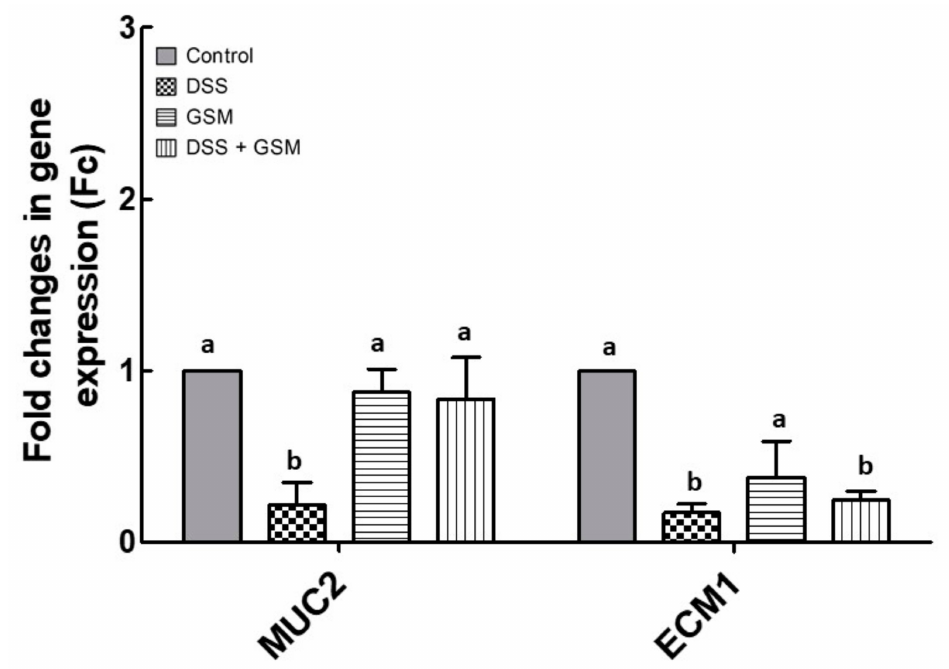
Figure 5. The effects of dietary treatments on genes are associated with barrier function damage in colon. MUC-2 and ECM1 gene expressions were evaluated in the colon of DSS-treated piglets by qPCR. The expression of target gene was normalized to the geometric mean of two reference genes; the results, expressed as fold changes (Fc) are presented as mean ± SEM. Values are the means from two independent replicates of colon samples ( n = 5/group), with their standard errors represented by vertical bars. a,b Groups with unlike superscript letters were significantly different ( p < 0.05; one-way ANOVA followed by Fisher